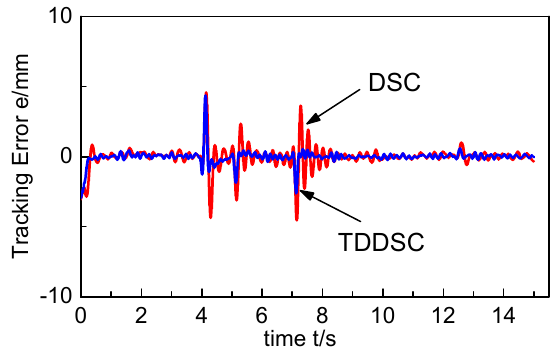
Figure 12. Tracking errors of the TDDSC and DSC algorithms as a function of time.